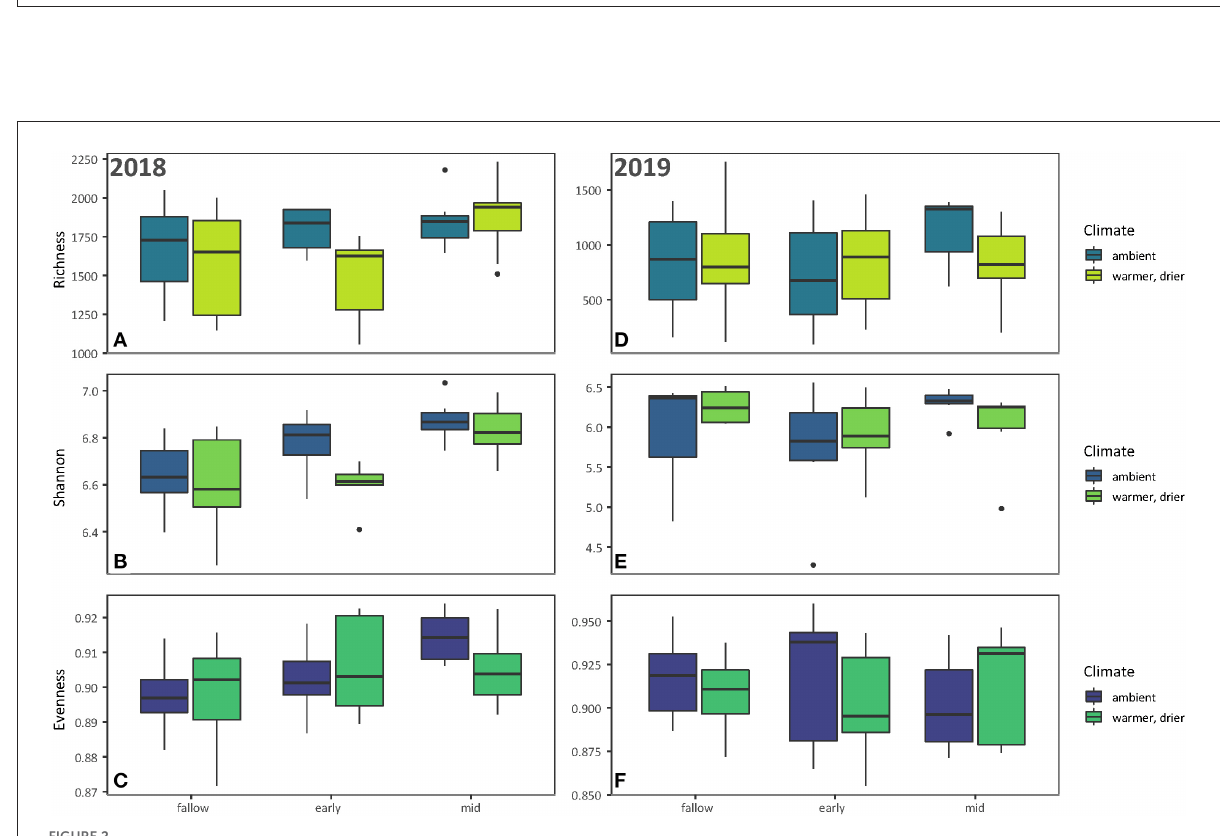
FIGURE2 Alpha diversity metrics of soil bacterial communities associated with early season cover crops, fallow soils, or mid-season cover crops in both ambient and warmer/drier conditions for each year. From top to bottom, (A–C) display bacterial community richness, Shannon’s Diversity, and Shannon’s Evenness for 2018. (D–F) display the same for